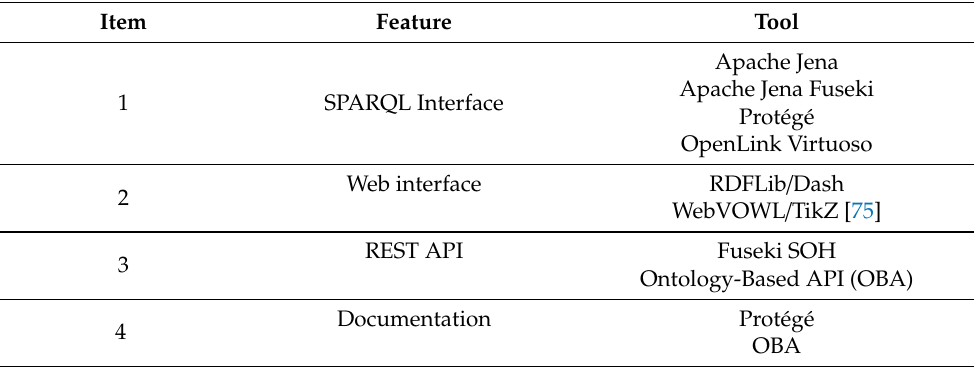
Table 12. OntoTouTra features.